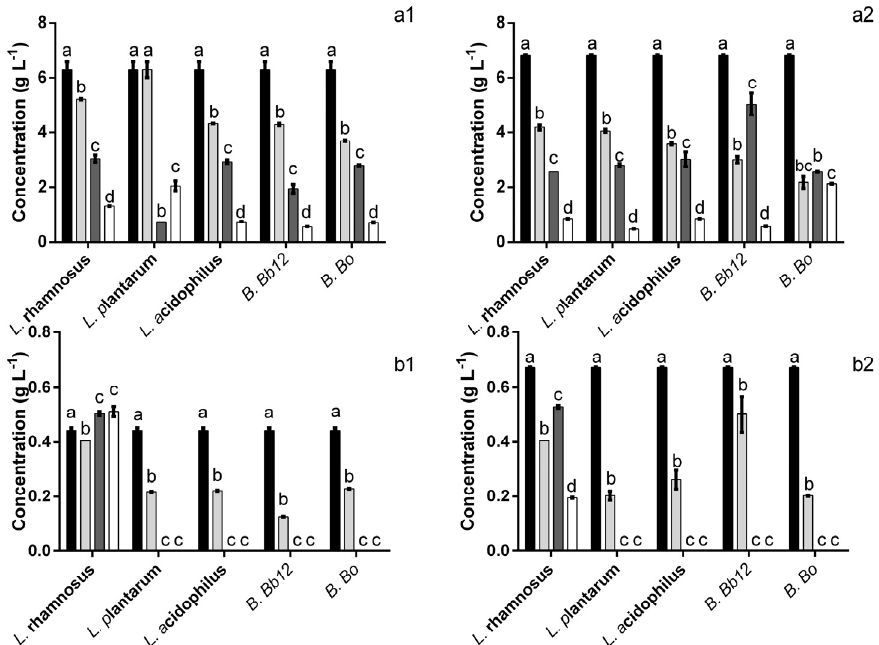
Figure 5. Concentration of glucose ( a ) and maltose ( b ) in the presence (1) and absence (2) of extract at 0 ( ■ ), 6 ( ■ ), 12 ( ■ ) and 24 ( ) h. The different letters mark the statistically significant ( p < 0.05) differences between the times for each individual microorganism assayed.